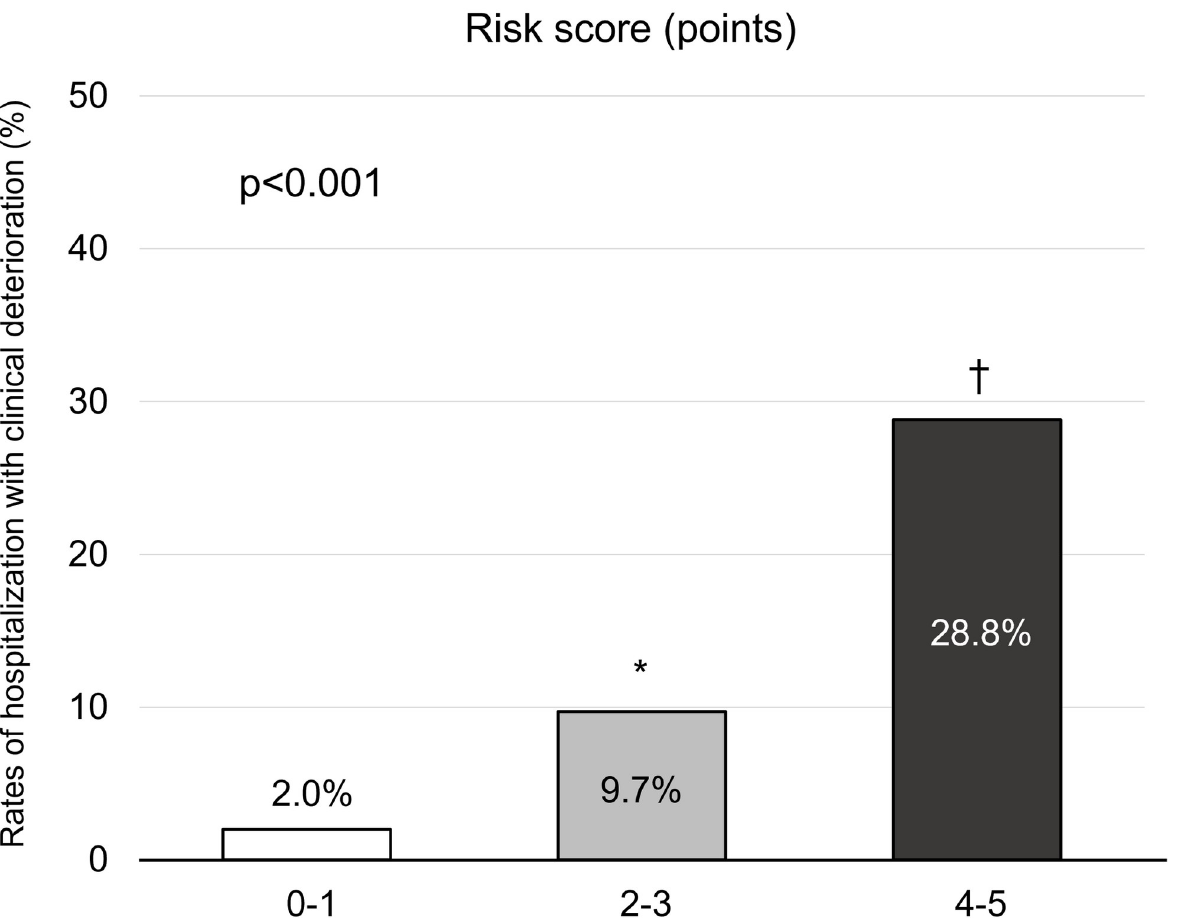
Fig 3. The hospitalization rate according to the risk scale score of COVID-19 severity identified in this study. The risk scale is shown in Table 3. Statistical analyses were performed with Fisher’s exact test, followed by Holm’s post hoc test for multiple comparisons. � p < 0.001 vs 0–1 points; † p < 0.001 vs 0–1 points and 2–3